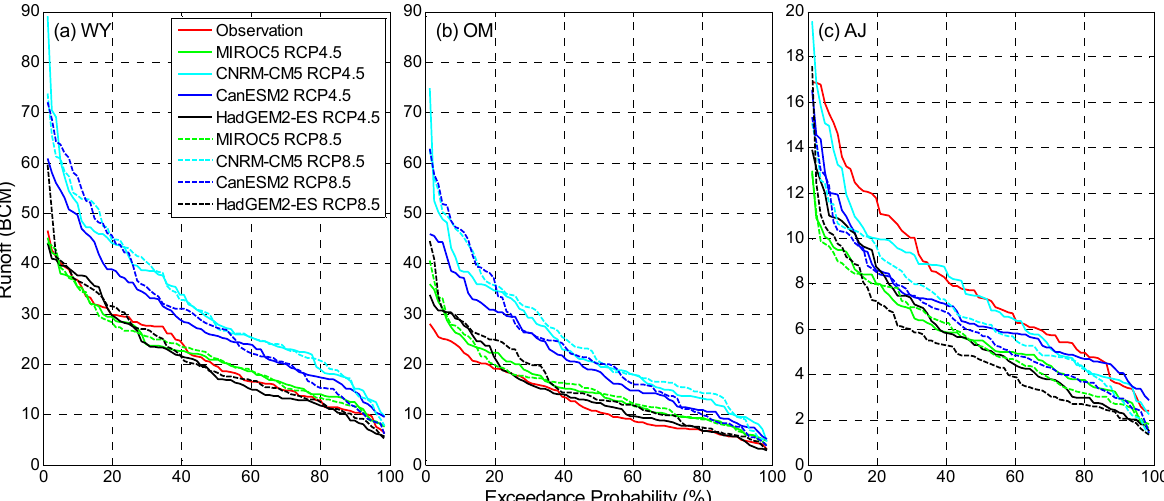
Figure 2. Exceedance probability curves for observed and projected ( a ) water year; ( b ) October–March; and, ( c ) April–July total SAC4 runoff volume. Note the scale difference in Y -axis across three panels.